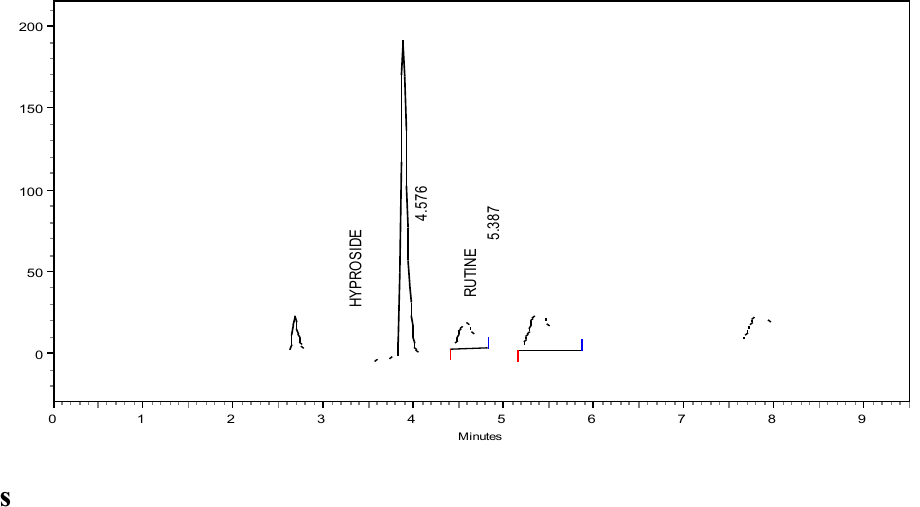
Figure 6. HPLC chromatographs of